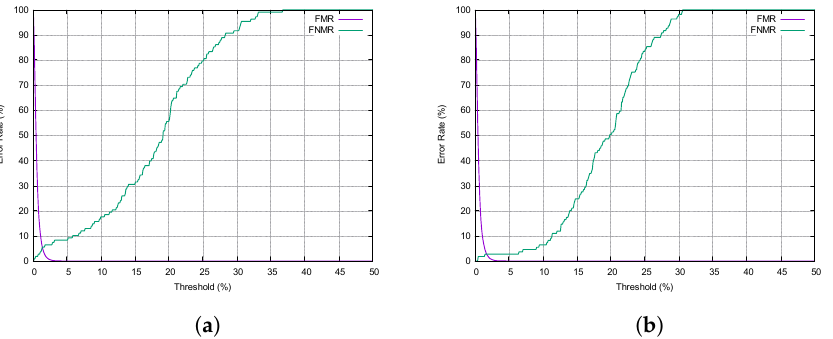
Figure 7. Comparison of OCT fingerprints and plain 2D fingerprints. ( a ) Outer fingerprint. ( b ) Inner